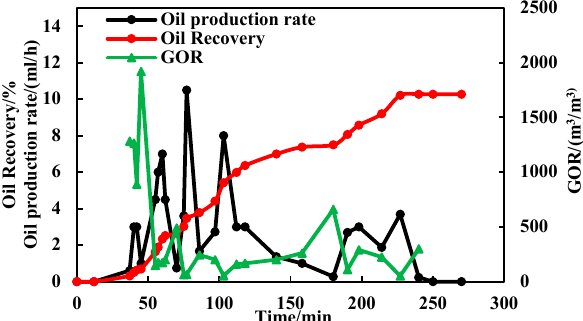
Figure 6. Production parameters of air HnP at different times.